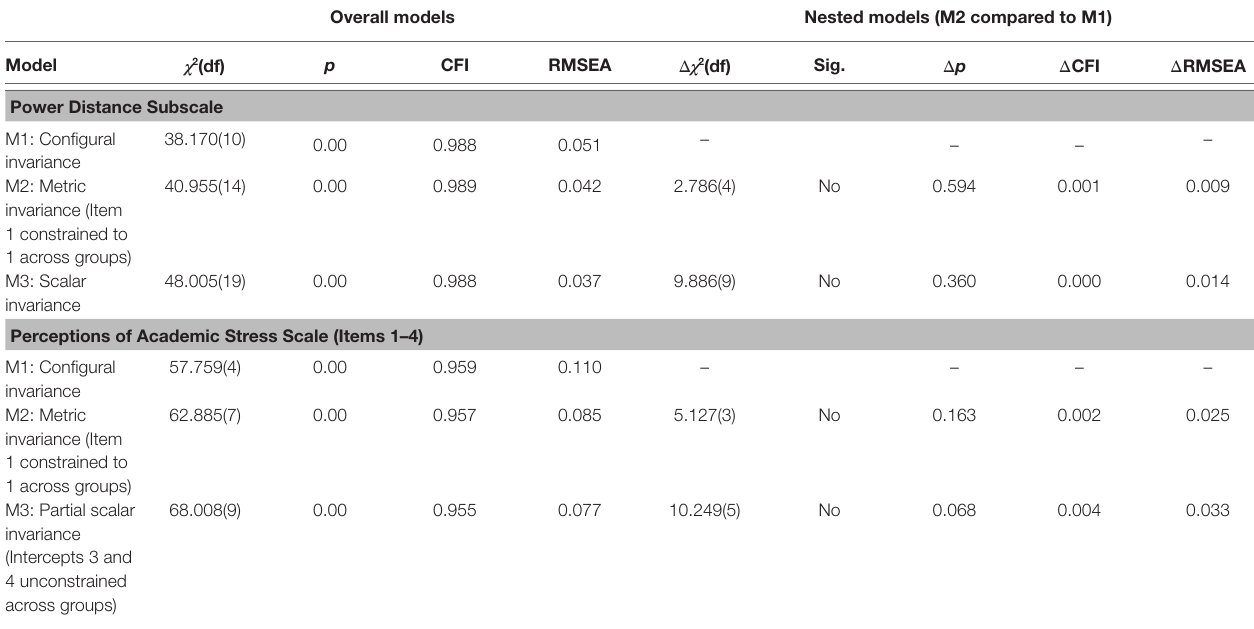
TABLE 2 | Fit indices for models of measurement invariance.